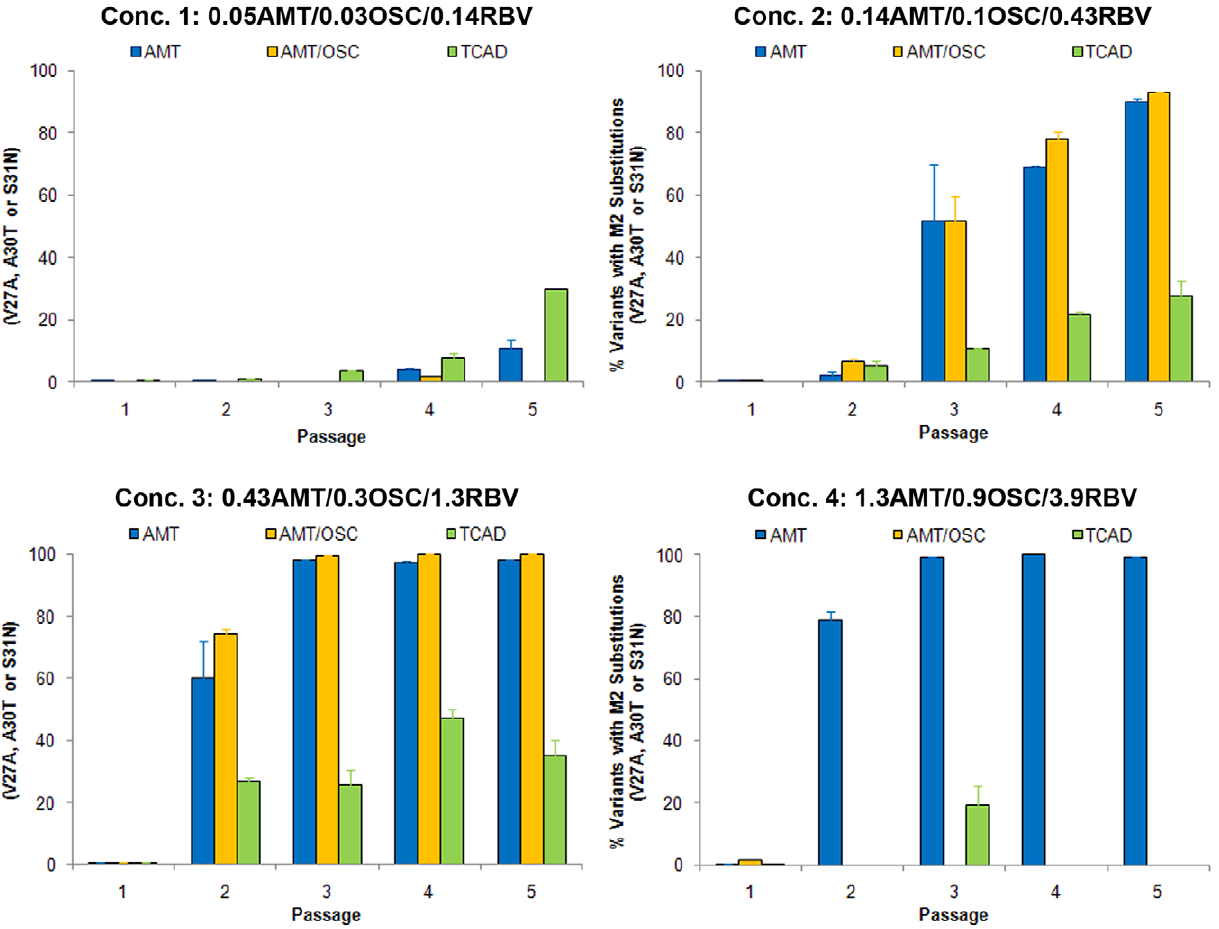
Figure 2. Percent of AMT-Resistant Virus Variants Generated as a Function of Passage Number. Wild type influenza A/Hawaii/31/2007 (H1N1) virus was passaged five times in MDCK cells, with the concentrations of drugs in each regimen kept fixed in between passages. The percent of virus variants bearing resistance-associated substitutions in M2 (V27A, A30T, or S31N) at each passage are presented as the mean of triplicate qASPCR reactions with 95% confidence intervals from a single well of MDCK cells. Each panel represents an increase in the concentration of each drug in the various regimens, with Concentration 3 representing the clinically relevant concentrations of all three drugs (see Materials and Methods). Drug concentrations are provided in units of m